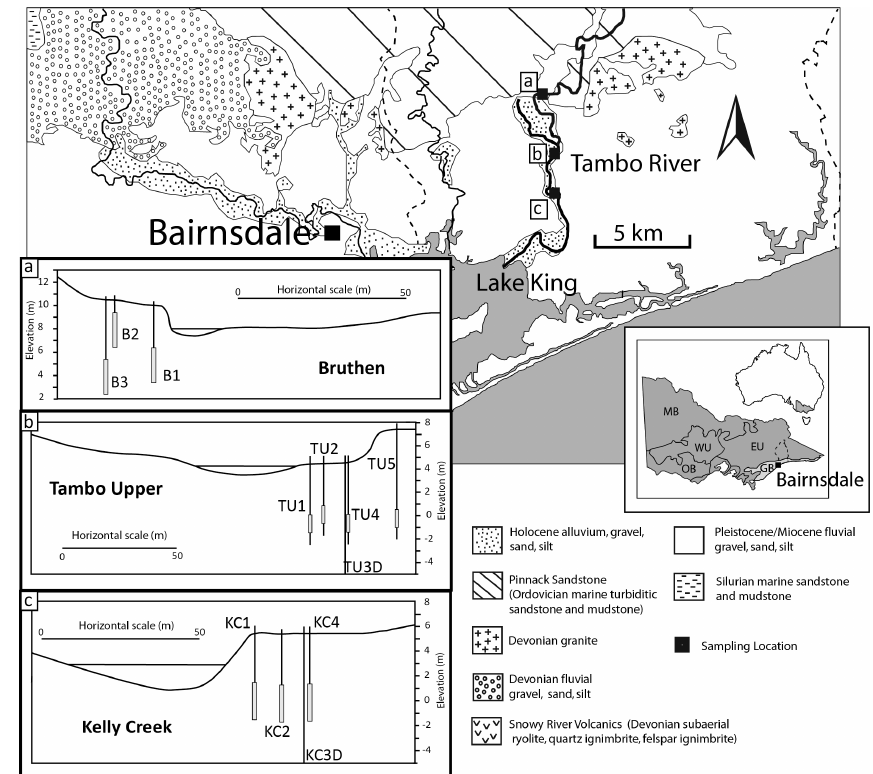
Figure 1. Location of field area and schematic cross sections of bore transects at Bruthen (a) , Tambo Upper (b) and Kelly Creek (c) . Screened sections indicated by open boxes. Dashed line represents Tambo River basin boundary (transects orientated facing upstream).